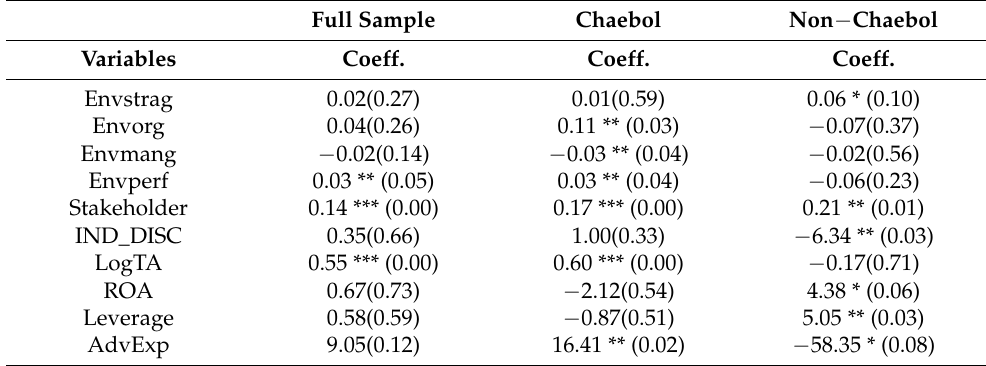
Table 8. Firm-value effects of decision to disclose carbon emission (H-2) using env. subset. Full